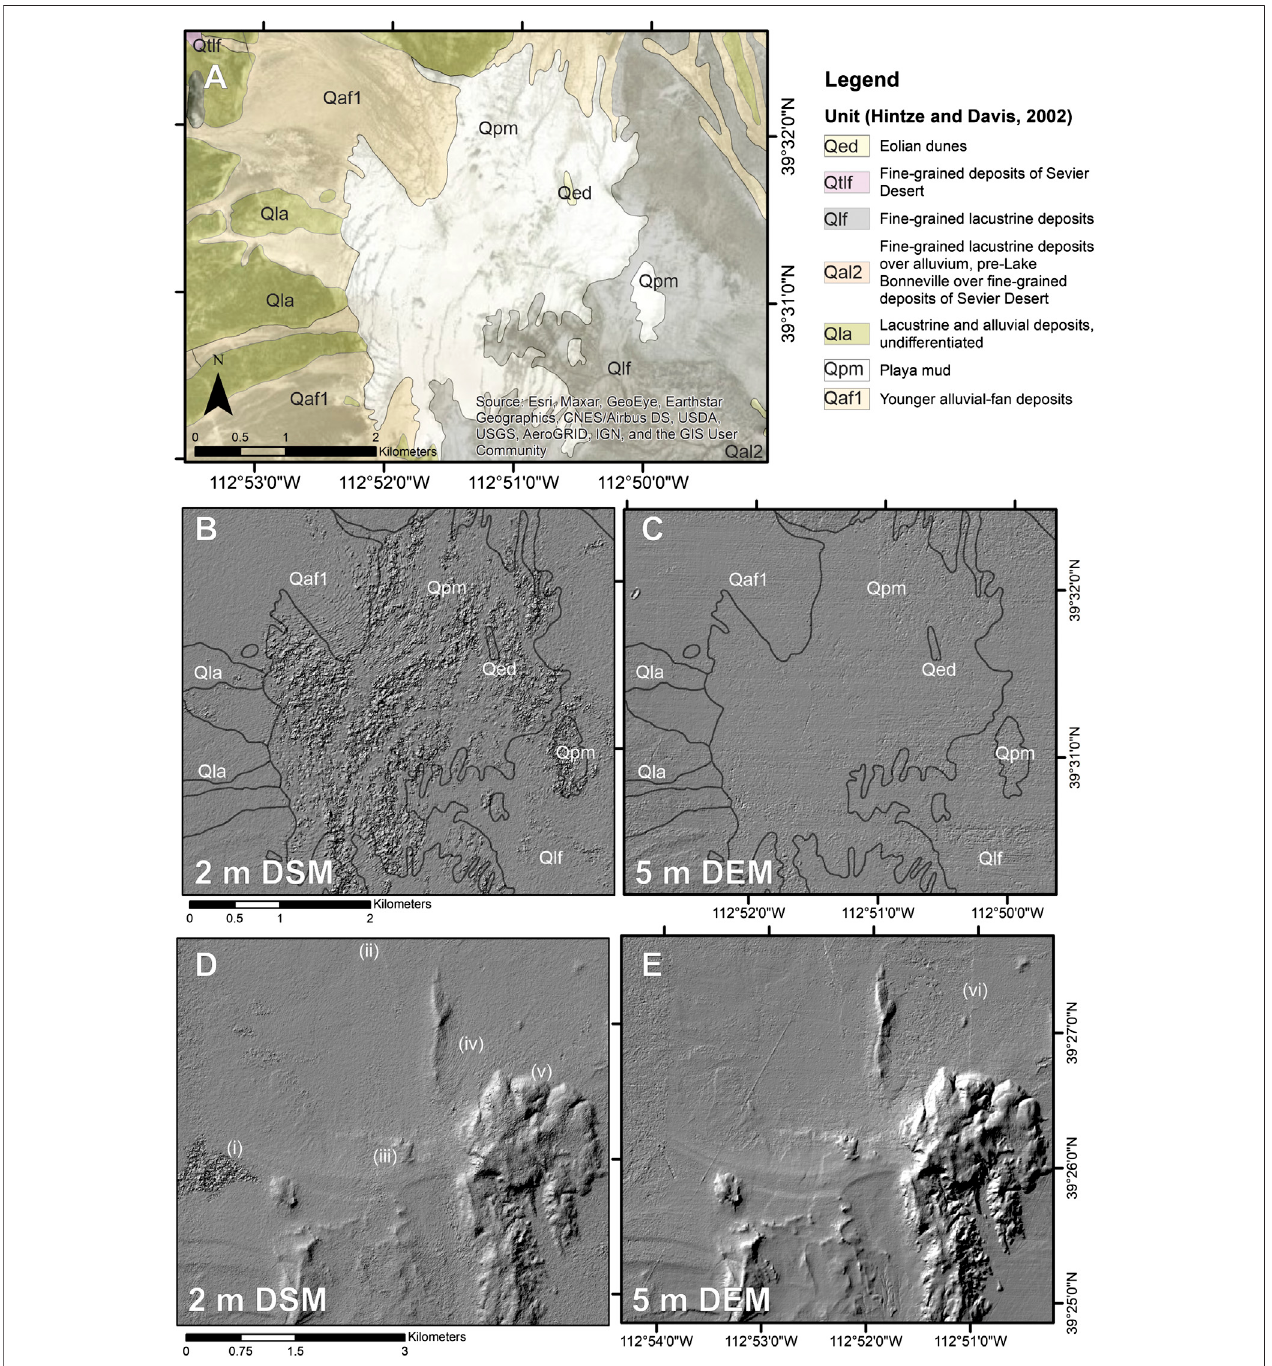
FIGURE 4 | A comparison of the 5-m AGRC DEM and 2-m DSM (produced from legacy aerial photographs) in different terrain and map units. (A) Map units from Hintze and Davis (2002) overlain on satellite photography. (B) and (C) demonstrate that the light-colored and re fl ective unit Qpm (playa mud) generates signi fi cant noise and artifacts in the 2-m DSM; color fi ltering in the processing of the 5-m DEM likely helps remove this effect. Surfaces that may be impacted by frequently occurring geomorphic processes (eolian transport/deposition; playa fl ooding and resurfacing) are also more likely to decorrelate over the decadal span of legacy aerial photograph collection than over the days or weeks needed to acquire the NAIP imagery. The 2-m DSM performs better in higher relief (D) but is still noisier and less ‘ sharp ’ relative to the 5-m DEM (E) . Roman numerals (i – v) in (D) indicate the locations to compare and contrast to the 5-m DEM in (E) . (I) Noise from unit Qpm; (ii) a fault scarp at the limit of detection in the DSM but clearer in the DEM; (iii) a fault scarp displacing a Provo-aged tombolo evident in both DSM and DEM; (iv) a radial fi ngerprint artifactgeneratedbyanareaof fl atterrainadjacentaridgeofbasalt;(v)locationofasharpProvoshorelinebenchinscribedintoSmelterKnoll(notevidentin (D) butvisible in (E) ); (vi) Shows a seamline artefact in the 5-m DEM not visible in (D) . Refer to Figure 2 for locations of A – C and D – E .